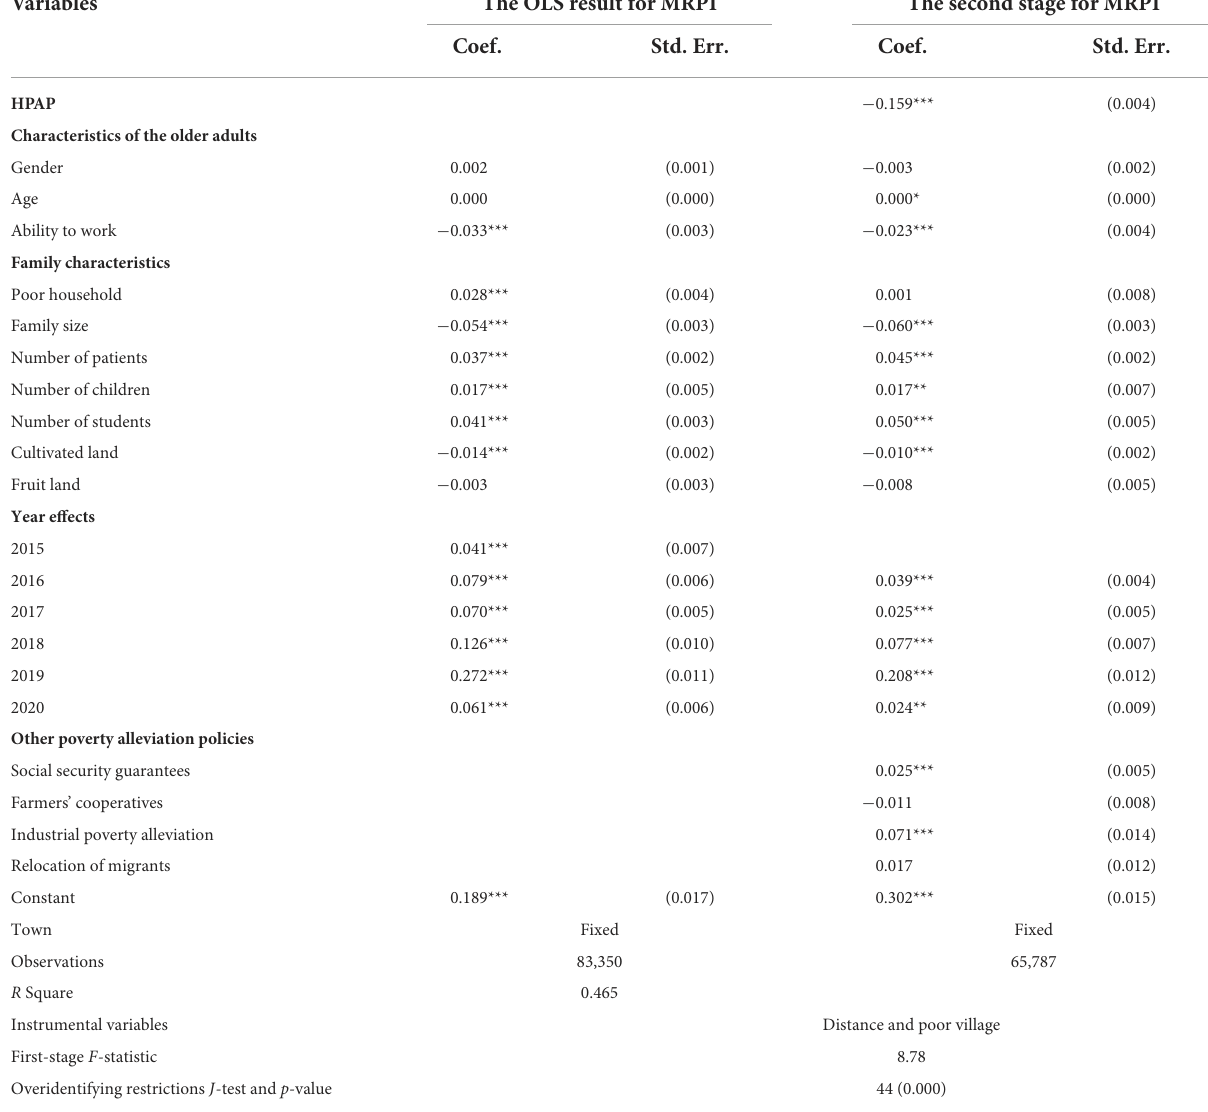
TABLE 5 Determinants of the MRPI and the impact of the HPAP on the MRPI. Variables The OLS result for MRPI The second stage for MRPI Coef. Std. Err.